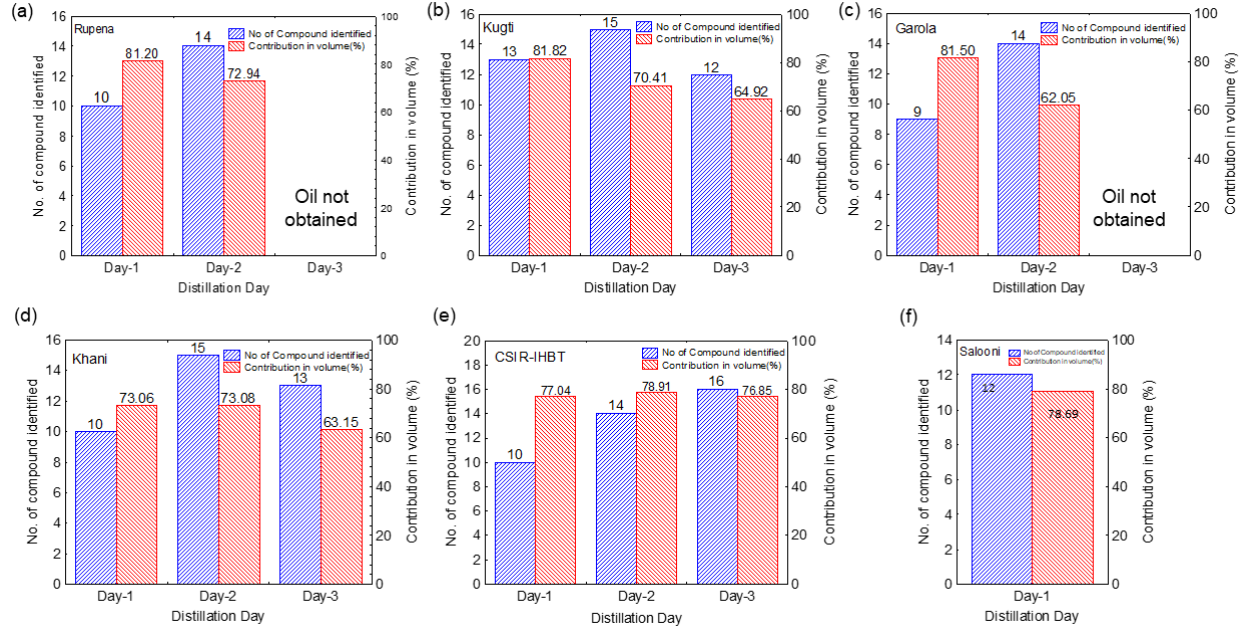
Figure 2. Number of volatile compounds identified and their contribution in volume (%) in the essential oil of V. jatamansi collected from Rupena ( a ), Kugti ( b ), Garola ( c ), Khani ( d ), CSIR-IHBT ( e ), and Salooni ( f ) under repetitive distillation method.